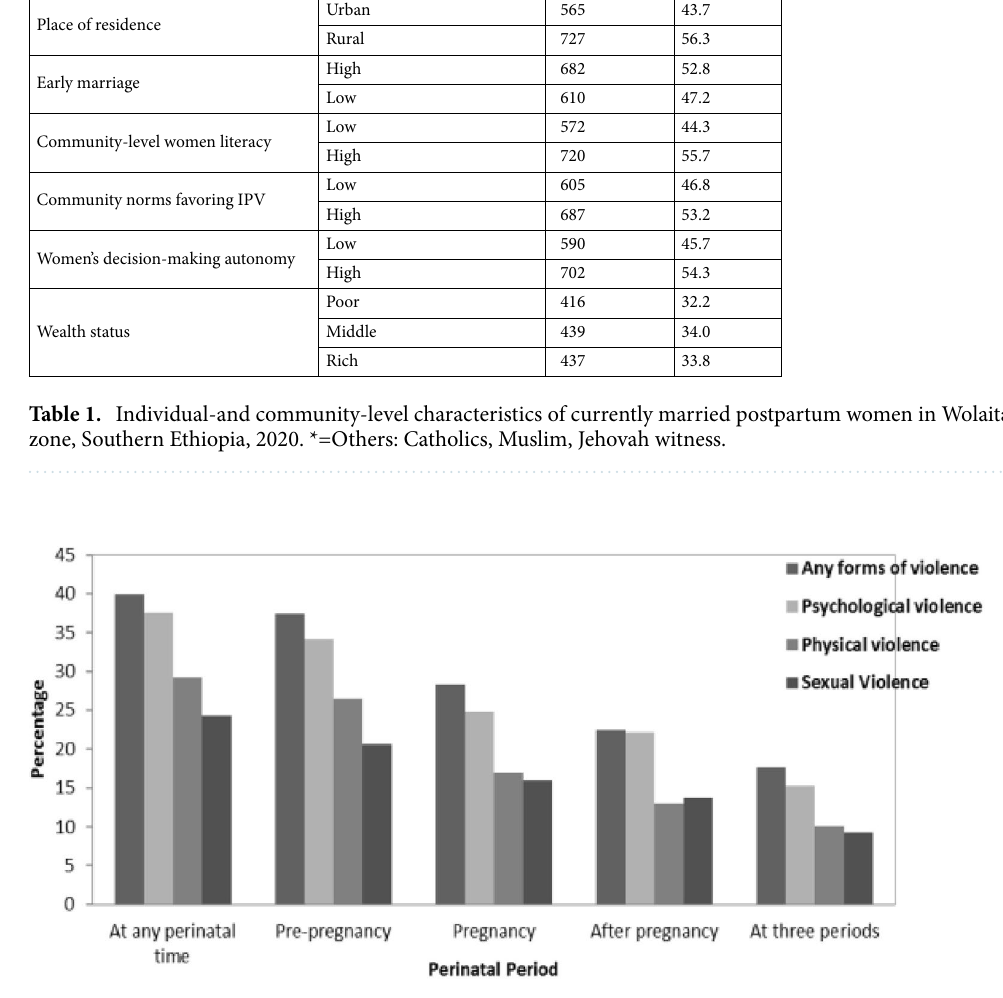
Figure 1. Patterns of self-reported perinatal partner violence according to the period of occurrence and its